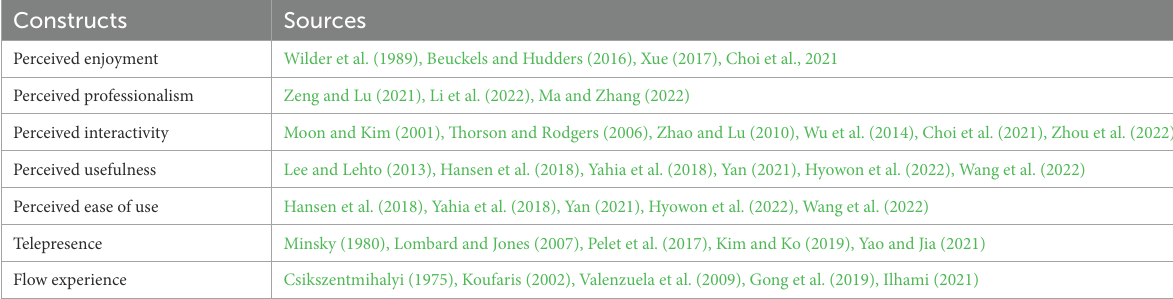
TABLE 1 Constructs and their